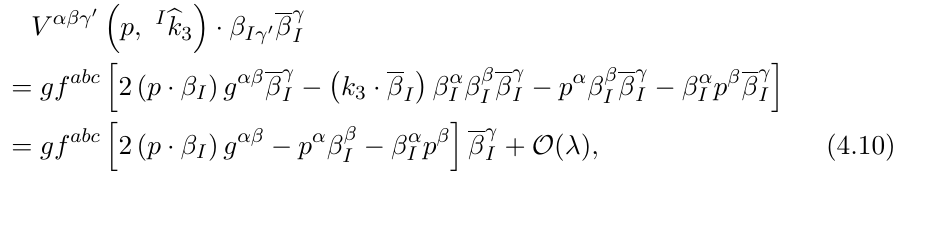
Figure 31. A three-gluon vertex V (cid:11)(cid:12)(cid:13) 0 (cid:12) I -component of the momentum k (cid:22) is also projected onto its (cid:12)